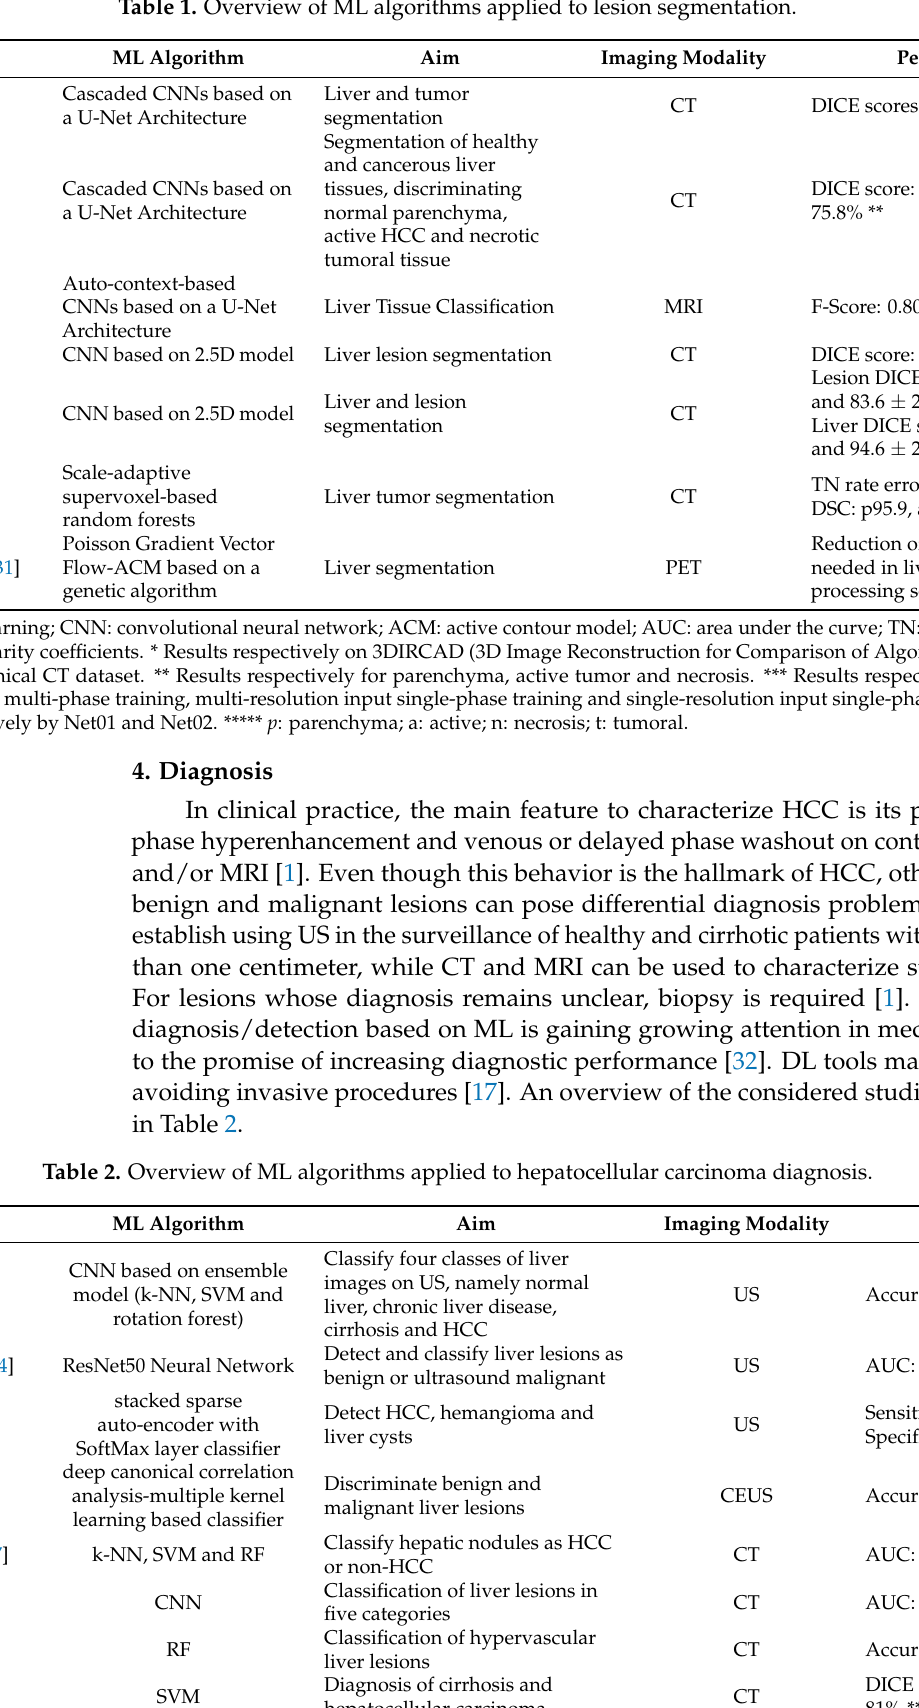
Table 1. Overview of ML algorithms applied to lesion segmentation.